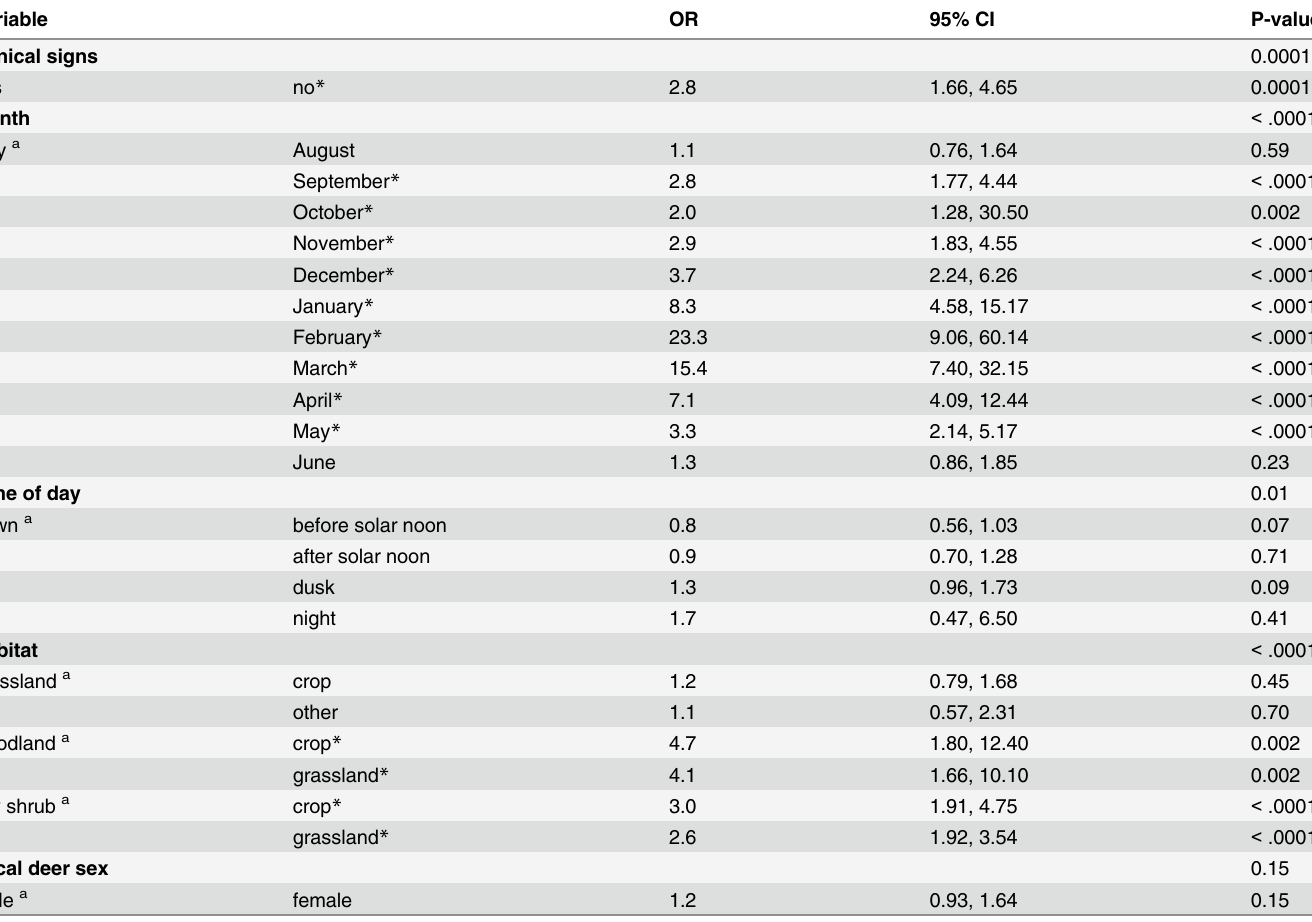
Table 3. The final multivariable model for the occurrence of groups of mule deer describing the strength of association with the presence of deer showing clinical signs, month, time of day, habitat, and sex of focal deer (n = 2173 groups). Variable OR 95% CI P-value